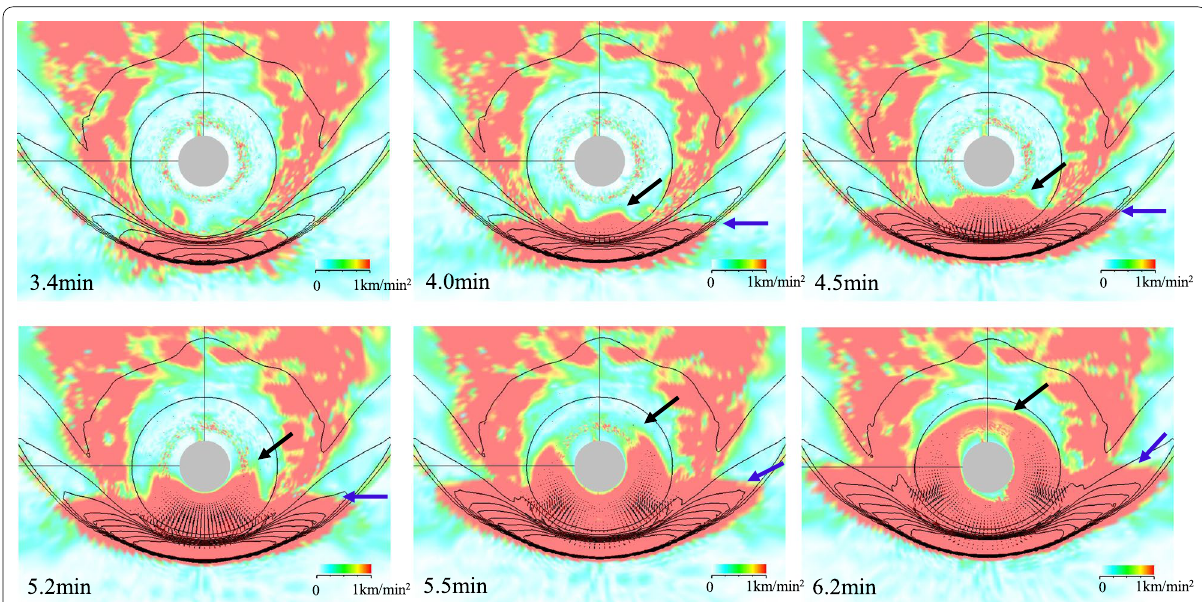
Fig. 11 Temporal spread of the magnetospheric SC signal front, indicated as the edge of the positive region of | d v d t | . The black and blue arrows in the panels of t 4.0 min to t 6.2 min indicate the SC front in the magnetosphere and the magnetosheath, respectively. It is evident that the = = SC front arrives at the night-side magnetosphere at 6.2 min, when the PI current system in the ionosphere does not reach the nightside. The line contours show the pressure in the equatorial plane. Irregular patterns of | d v d t | in the night-side magnetosphere are fluctuations. We do not discuss the fluctuations in this paper because they do not play any roles in the propagation of the SC signal